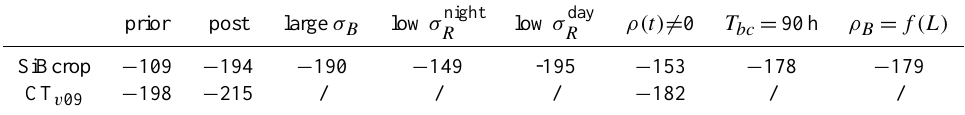
Table 1. Regional CO 2 flux balance from June to December 2007 in TgC over the MCI using Sibcrop and CarbonTracker2009 as prior fluxes in the reference setup (prior and posterior), then assuming larger uncertainties in the prior (= larger σ B ), more confidence in nighttime data i.e. 10ppm instead of 100ppm (=lower σ night ), more confidence in daytime data i.e. 2ppm instead of 3ppm for the lower limit (=lower R σ day ),temporal correlations in hourly observation errors between the hour t with the following n hours (= ρ (X R longer time period to correct for boundary influence (= T bc = 90h), and prior error correlations based on distance only ( ρ B = f (L)